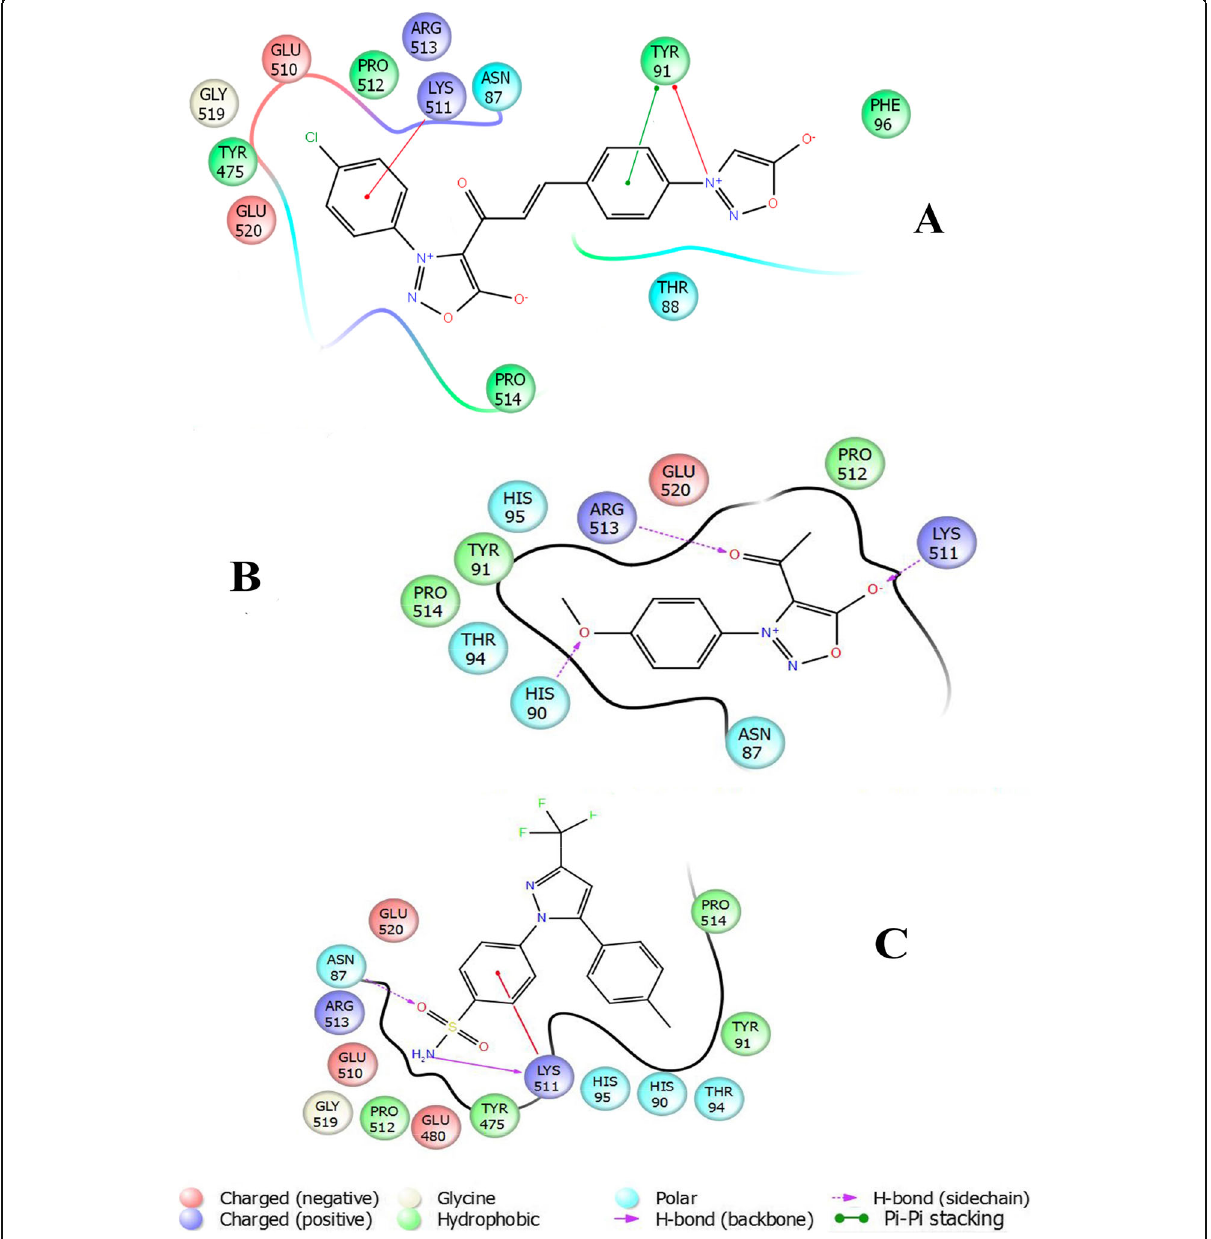
Fig. 6 Binding pose of 63 ( a ), 51 ( b ) and celecoxib ( c ) with the active site of